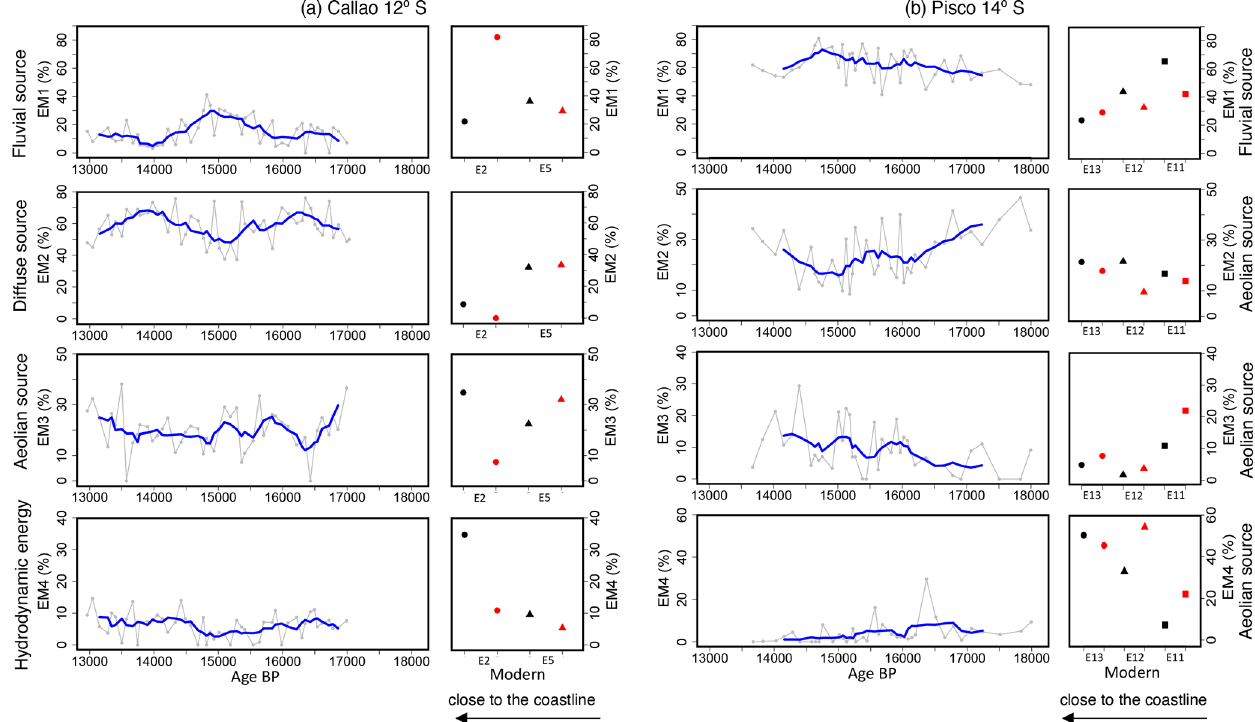
Figure 6. Variations in the contribution of the grain-size end-members from marine cores and surface sediments in Callao (a) and Pisco (b) . The modern period is represented by the mean end-member contribution of surface sediments collected during normal conditions (black symbols) and the coastal El Niño April 2017 event (red